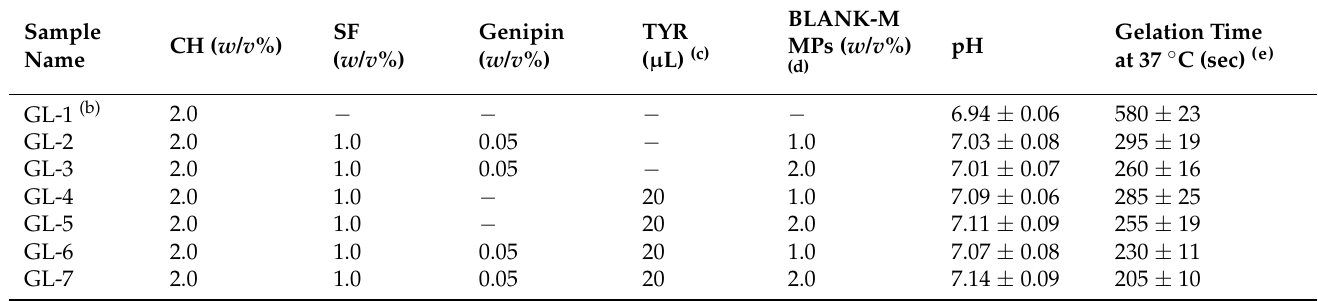
Table 2. Parameters for hydrogels embedded with blank core-shell microspheres (a)